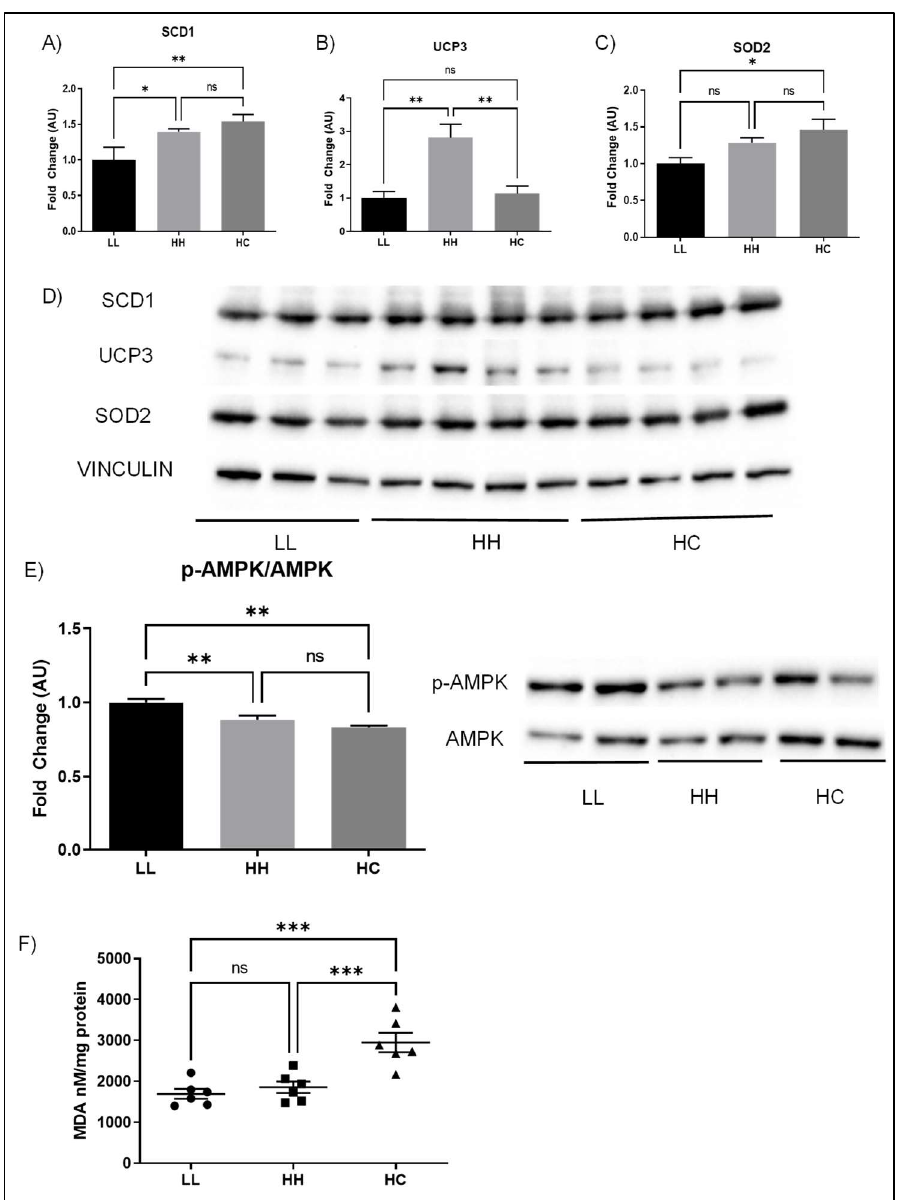
Figure 6. Effects of diet on metabolic proteins. ( A ) SCD1; ( B ) UPC3; ( C ) SOD2; ( D ) the representative blots are shown, and the protein levels were normalized with vinculin; ( E ) p-AMPK/AMPK with a representative blot; and ( F ) MDA, a marker of oxidative stress. SCD1, stearoyl-coenzyme A desaturase 1; UCP3, uncoupling protein 3; SOD3, superoxide dismutase 2, mitochondrial, also known as manganese superoxide dismutase; AMPK, AMP-activated protein kinase; MDA, malondialdehyde; LL, offspring born from maternal LFLS and postnatal LFLS indicated by closed circles (●); HH, maternal HFHS and postnatal HFHS indicated by closed squares ( ■ ); HC, maternal HFHS weaned onto a standard laboratory chow diet indicated by a closed triangle ( ▲ ). Values are presented as mean ± SEM. Statistical significance is calculated by one-way ANOVA with post hoc Fisher’s LSD comparisons. A total of 3–4 animals per group were used with 4 technical replicates per animal for the Western blot and n = 6/group was used for measuring MDA levels. * p < 0.05; ** p < 0.01; *** p < 0.001; ns, not significant.